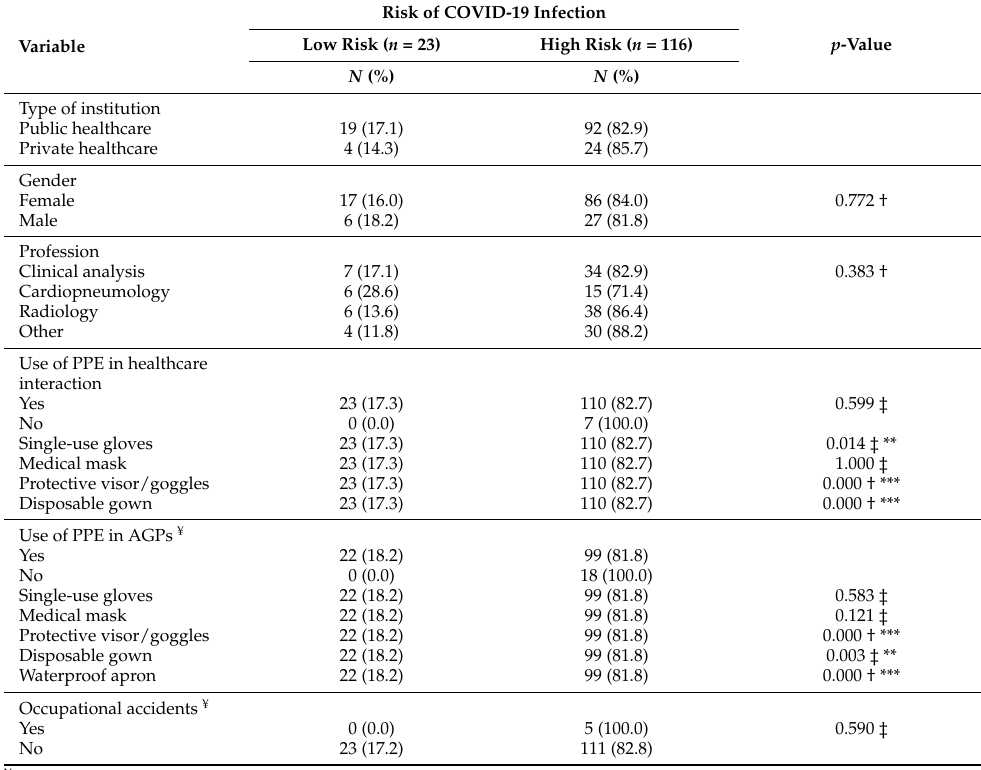
Table 5. Association between variables and risk of COVID-19.